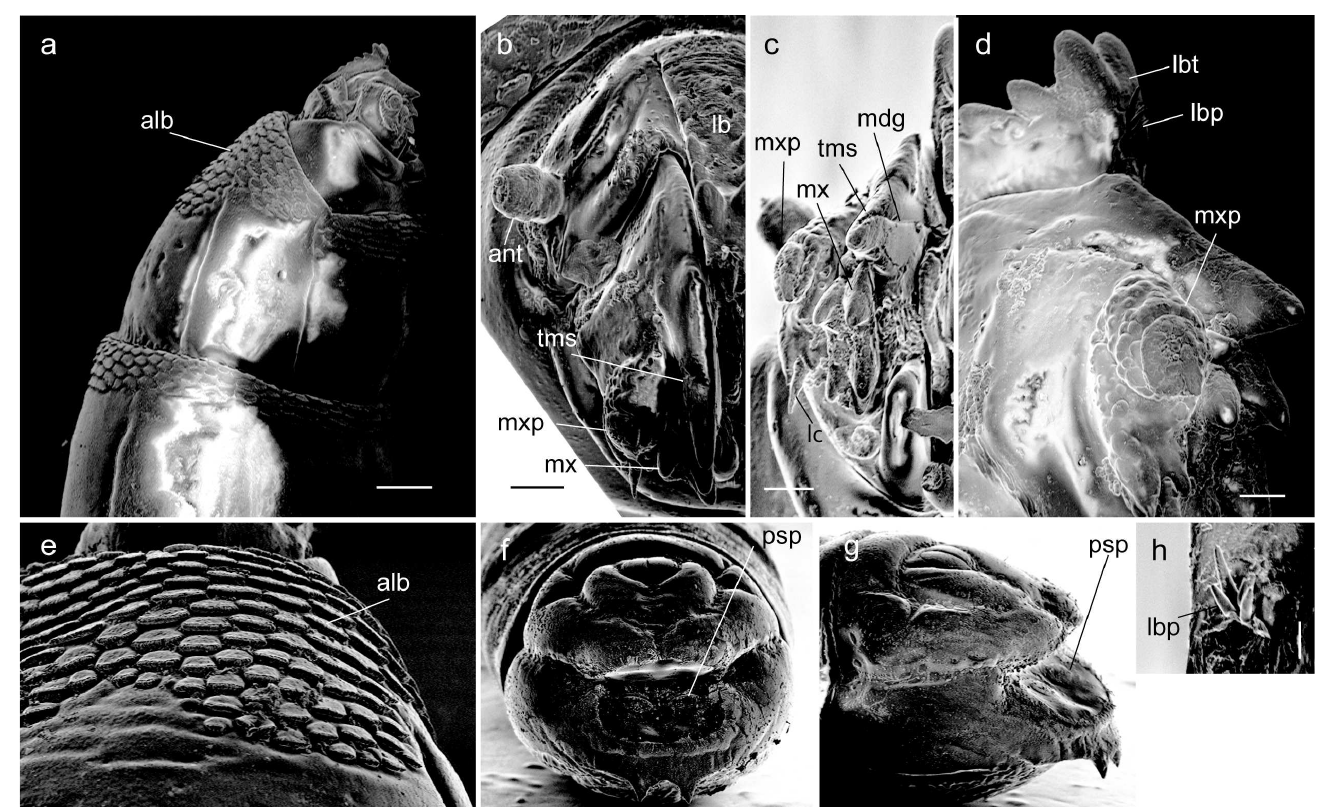
Fig 4. Larva of Ptiolina sp., SEM views. (a) Anterior part of body, lateral view (100 μ m); (b) head, dorsofrontal view (30 μ m); (c) anterior part of body, frontal view (30 μ m); (d) anterior part of body, outer view (20 μ m); (e) first thoracic segment, inner view (30 μ m); (f) last abdominalsegment, posteroventral view (30 μ m); (g) last abdominal segment, obliqueventral view (30 μ m). Scale lengths in parentheses. Abbreviations : ant = antenna; alb = anterior lobes of cuticle; tms = upper tooth of apicalmandibularsclerite; lb = labrum; lbp = labral papillae; lbt = labral teeth; lc =